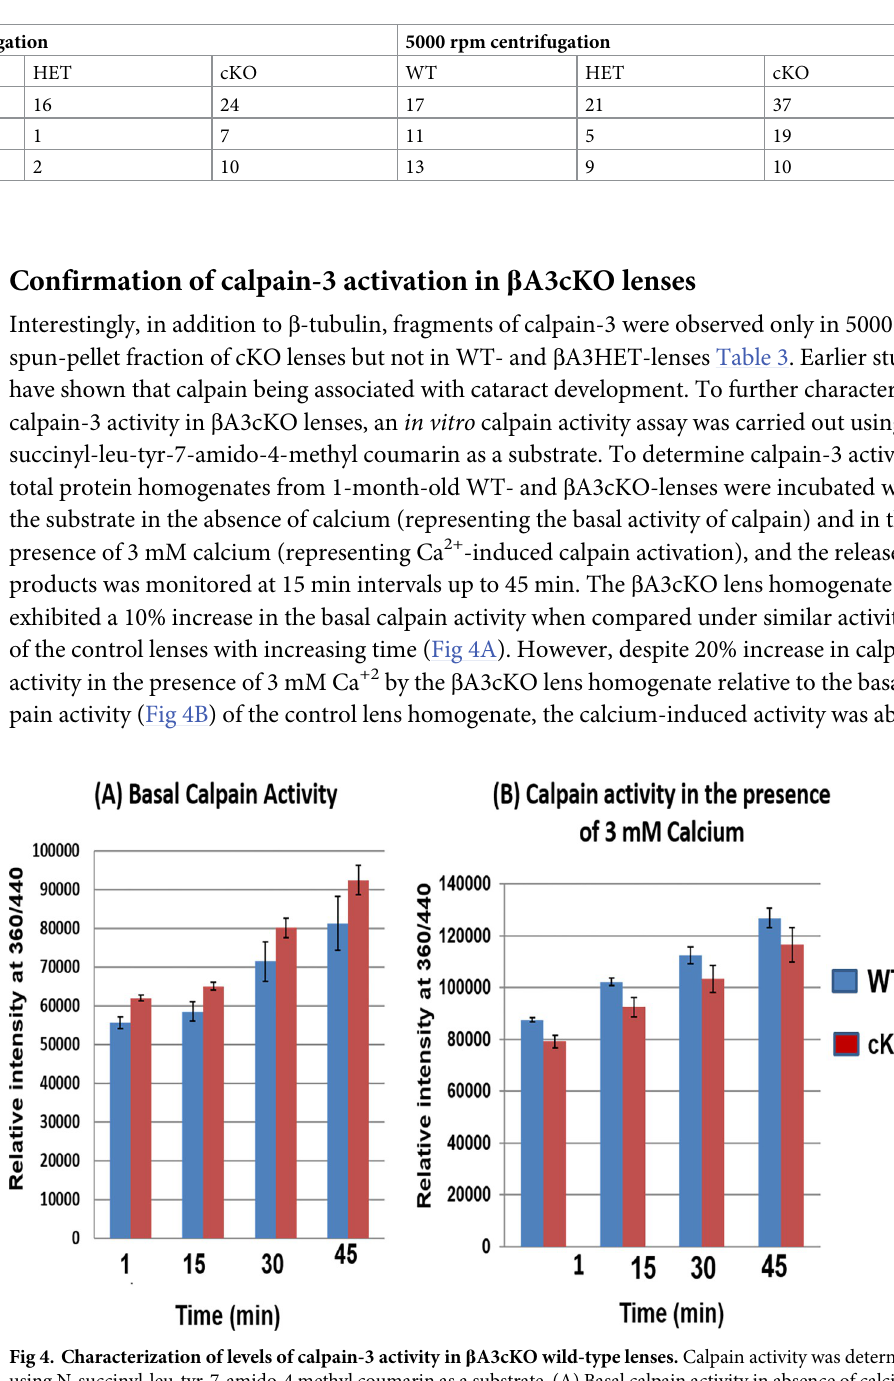
Fig 4. Characterization of levels of calpain-3 activity in β A3cKO wild-type lenses. Calpain activity was determined using N-succinyl-leu-tyr-7-amido-4 methyl coumarin as a substrate. (A) Basal calpain activity in absence of calcium chloride in homogenates of β A3cKO- and wild-type lenses. The β A3cKO lens homogenate exhibited a 10% increase in basal calpain activities compared to the wild-type lenses with increasing time, ( B) Calpain activity in the presence of 3 mM calcium chloride in homogenates of β A3cKO- and wild-type- lenses. About 10% decrease in calpain-3 activity in the presence of 3 mM Ca +2 was observed by the β A3cKO lens homogenate relative wild-type lens homogenate.